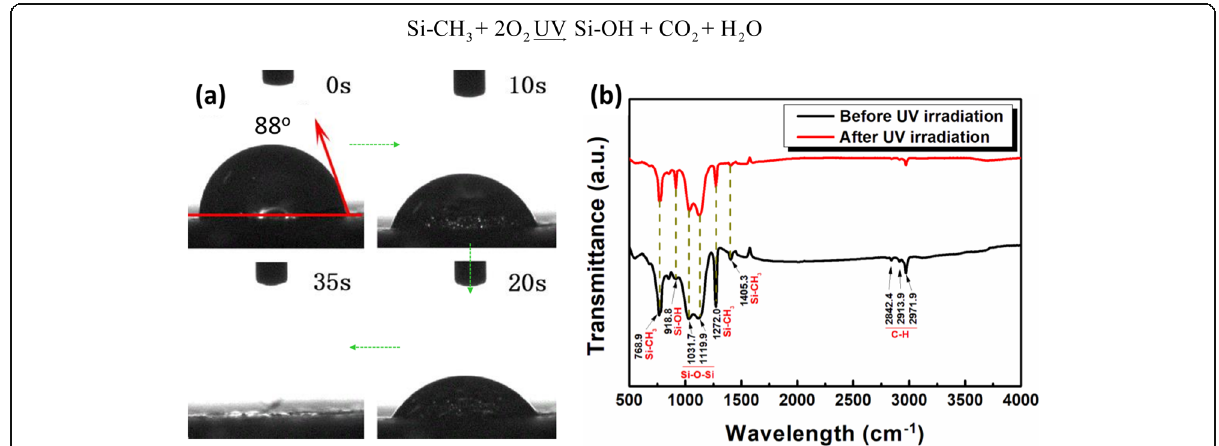
Fig. 9 a Contact angle of the membrane after UV-light irradiation and b FTIR spectra of pure membrane